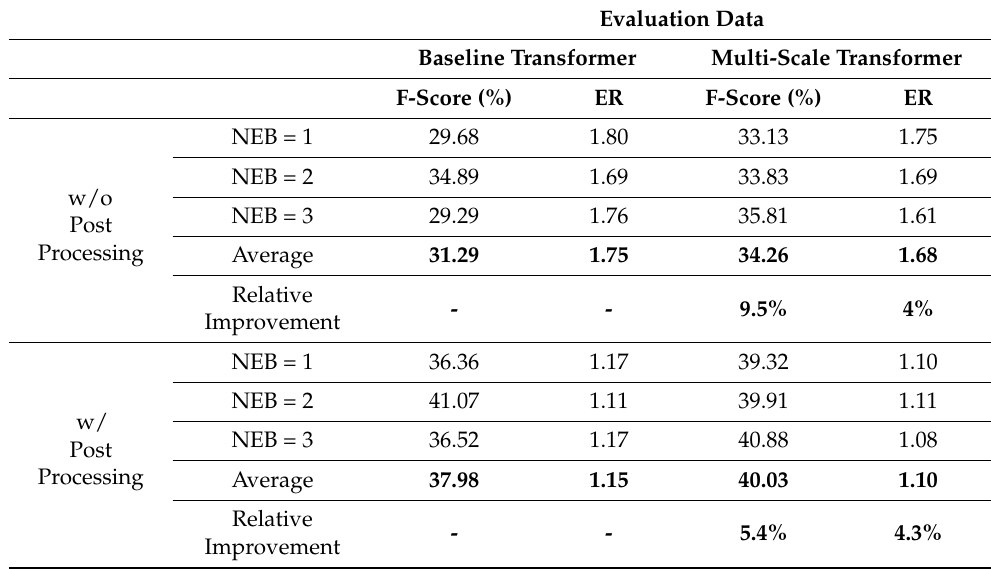
Table 4. Comparison of event-based SED results on evaluation data between baseline Transformer model and multi-scale Transformer